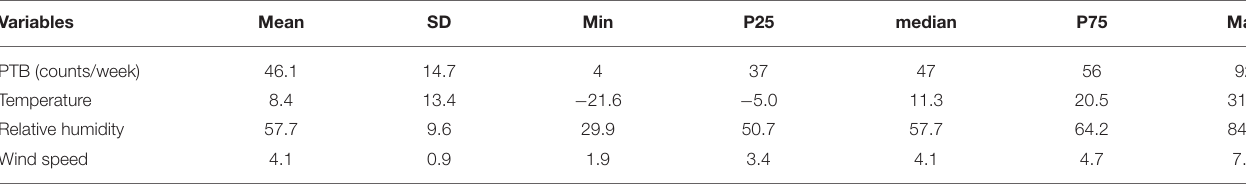
TABLE 1 | Description of meteorological factors and pulmonary tuberculosis (PTB) in Urumqi.